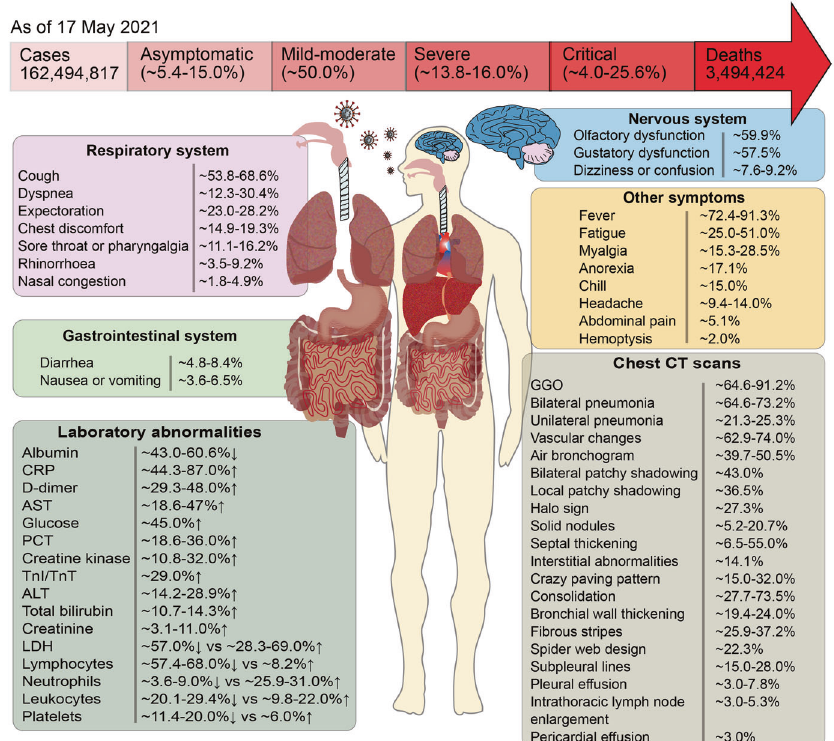
Fig. 2 Overview of clinical characteristics of COVID-19. CRP C-reactive protein, AST aspartate aminotransferase, PCT procalcitonin, TnI/TnT troponin I/troponin T, ALT alanine aminotransferase, LDH lactate dehydrogenase, CT computed tomography, GGO ground-glass